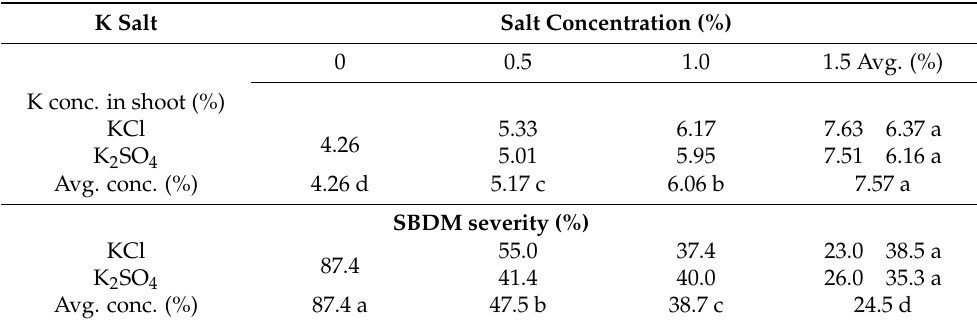
Table 2. Effects of foliar applications of KCl and K 2 SO 4 on the K concentration in the shoots and the severity of sweet basil downy mildew